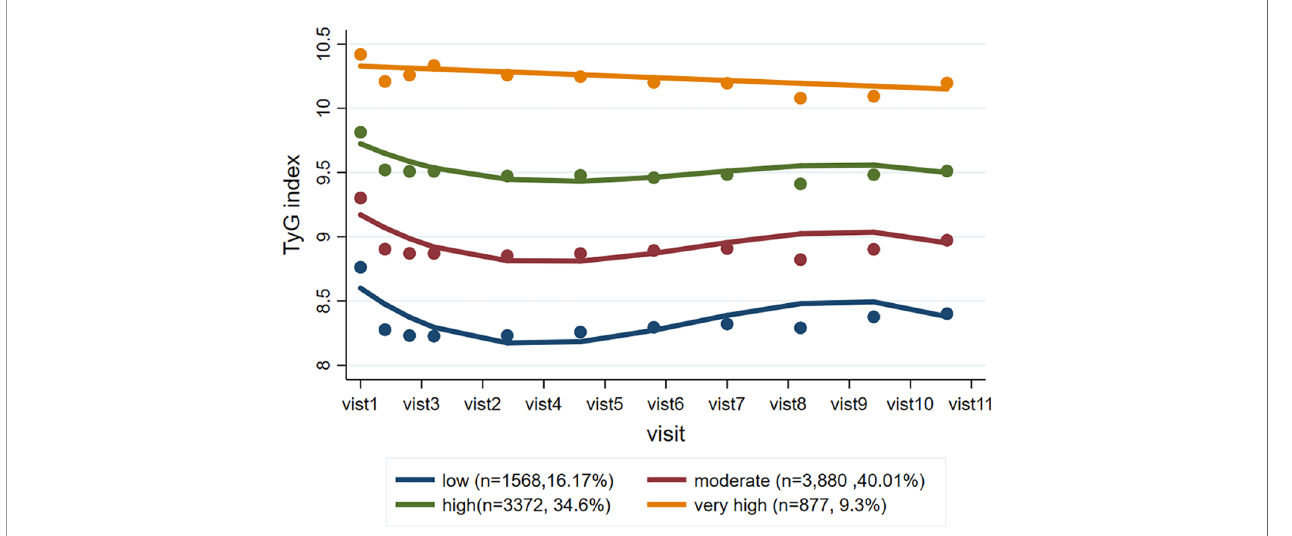
FIGURE 2 | TyG index trajectory groups and percentage of the population in the group. Four discrete trajectories with stable TyG indexes at various levels from visit 1 to visit 11: low (n = 1,568, 16.17%), moderate (n = 3,880, 40.01%), high (n = 3,372, 34.60%), and very high (n = 877, 9.30%) TyG index trajectory groups. TyG, triglyceride-glucose.